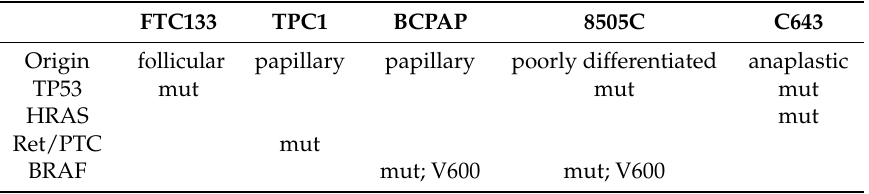
Table 1. Schematic representation of cell lines used in the study. Origin specification and mutation panel. FTC133 TPC1 BCPAP 8505C C643 Origin follicular papillary papillary poorly differentiated anaplastic TP53 mut mut mut HRAS mut Ret/PTC mut BRAF mut; V600 mut;